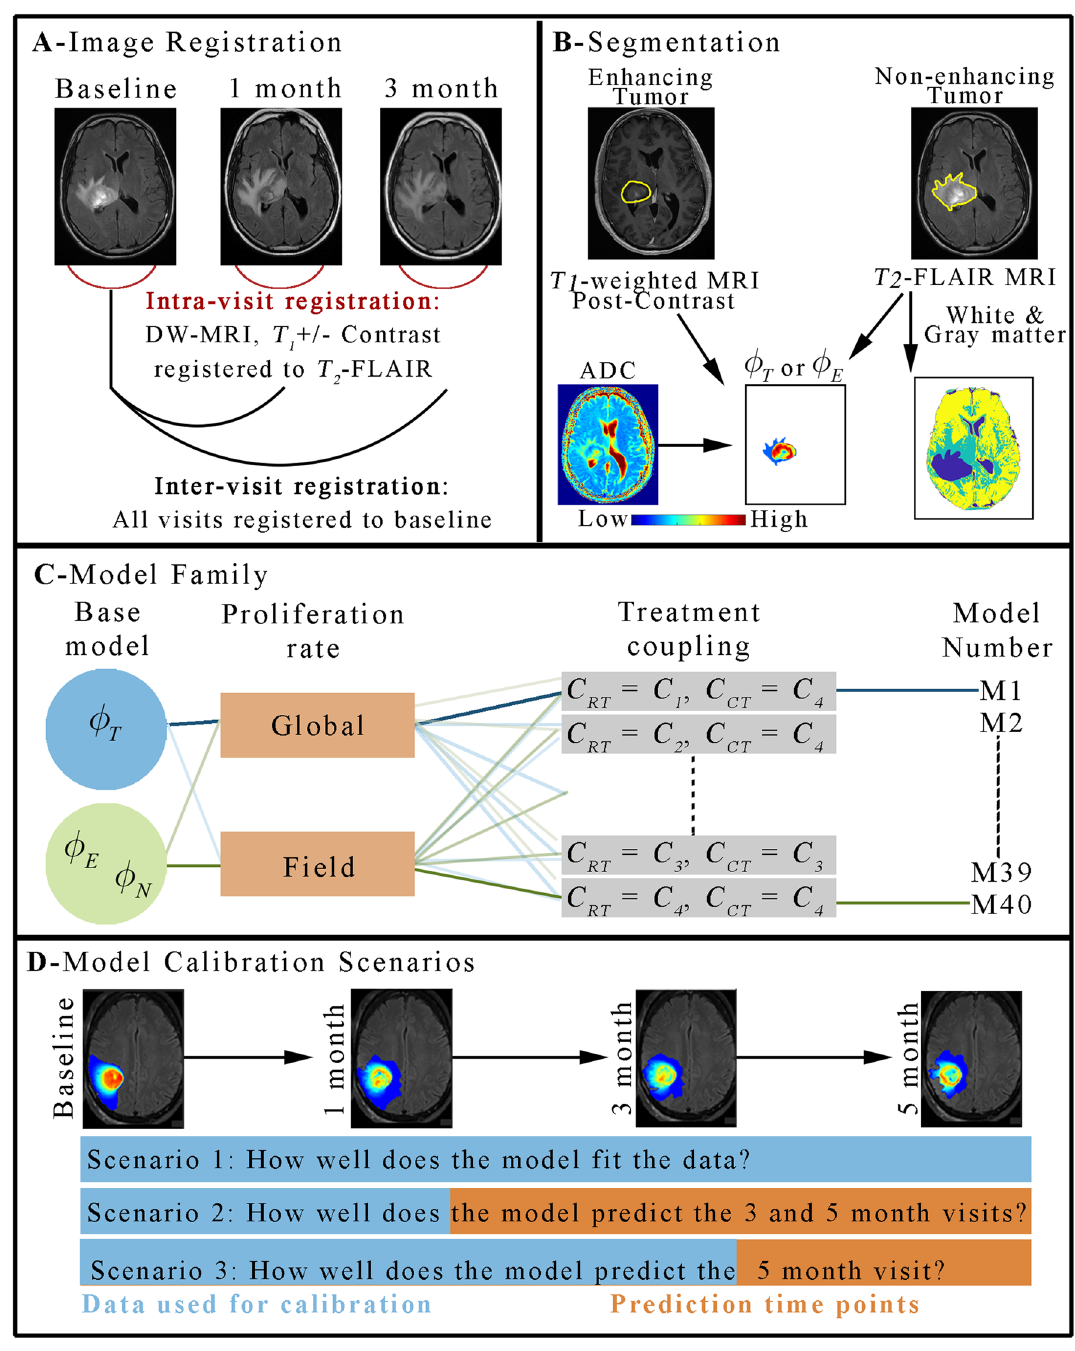
Figure 1. Schematic of the image processing and computational methods. Panel ( A ) shows the approach to image registration where all images first receive an intra-visit registration to align all images within a single visit prior to an inter-visit registration to the baseline time point. Panel ( B ) shows the expertly segmented contrast- enhancing and non-enhancing ( T 2 hyperintense) tumor regions which are used as ground truth of enhancing tumor and non-enhancing clinical tumor volumes, respectively. DWI measurements of ADC are then used to